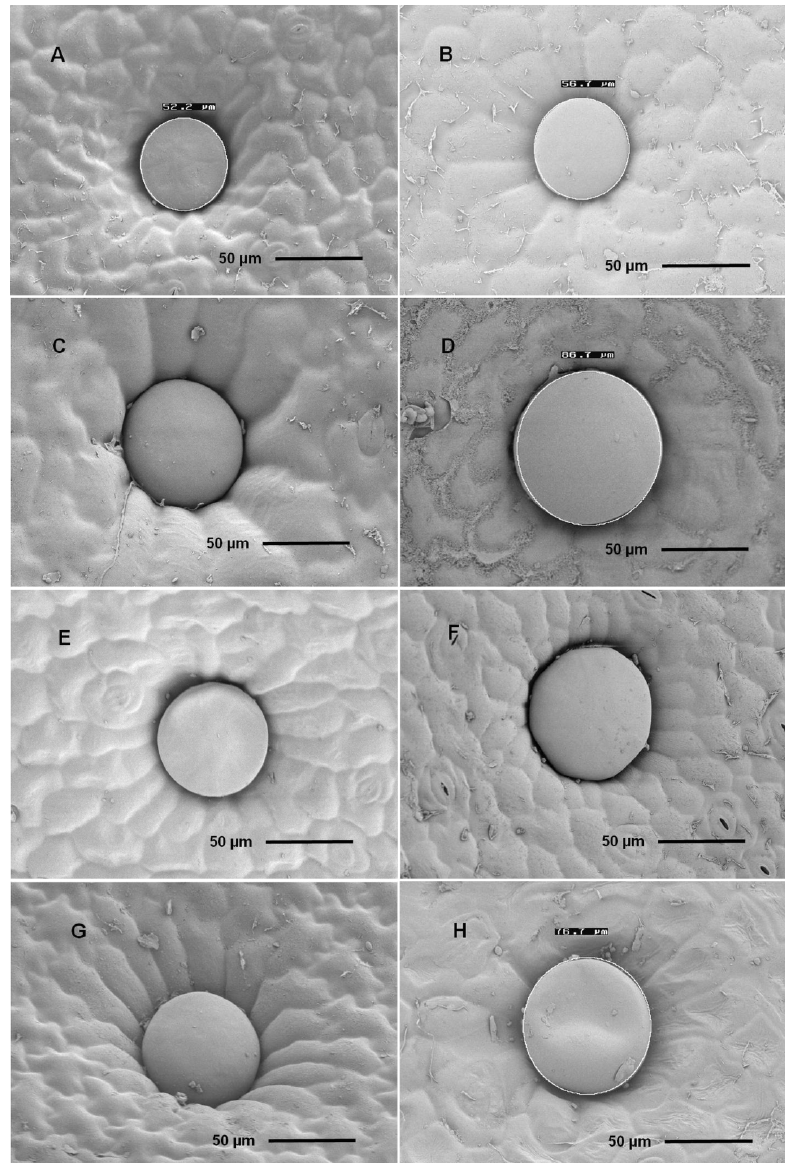
Fig. 2: Size of peltate glandular trichomes of four Origanum vulgare L. accessions under two light intensity conditions (RLI: reduced light intensity, FLI: full light intensity (SEM × 50). A, C, E and G) RLI condition; B, D, F, H) FLI condition A, B) Origanum vulgare L. ssp. vulgare C, D) Origanum vulgare L. ssp. hirtum (Link) letswaart E, F) Origanum vulgare L. ssp. viride (Boiss.) Hayek G, H) Origanum vulgare L. ssp. viride (Boiss.) Hayek × O. majorana